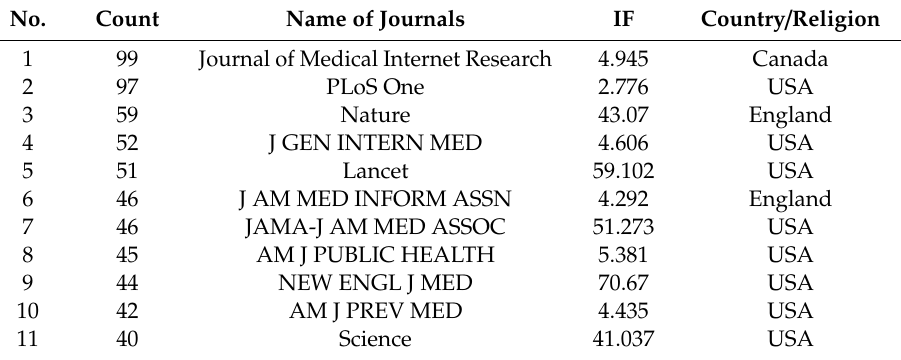
Table 4. Top 11 high-profile and high-cited